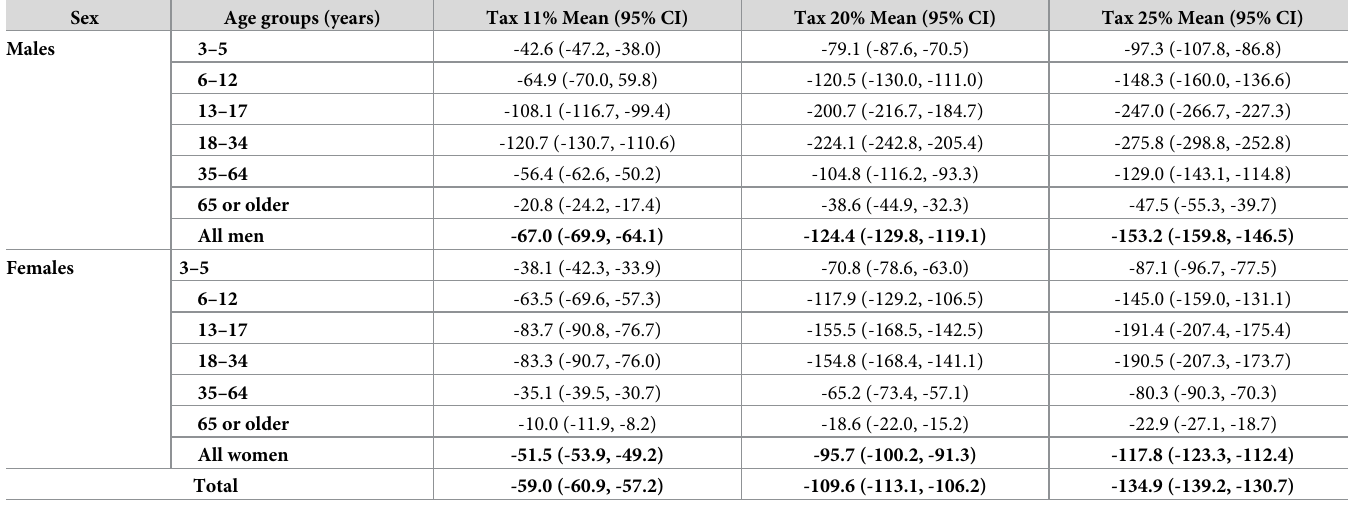
Table 2. Estimated change in energy intake (kJ/day/person) after a 11%, 20% and 25% SSB tax by sex and age groups.